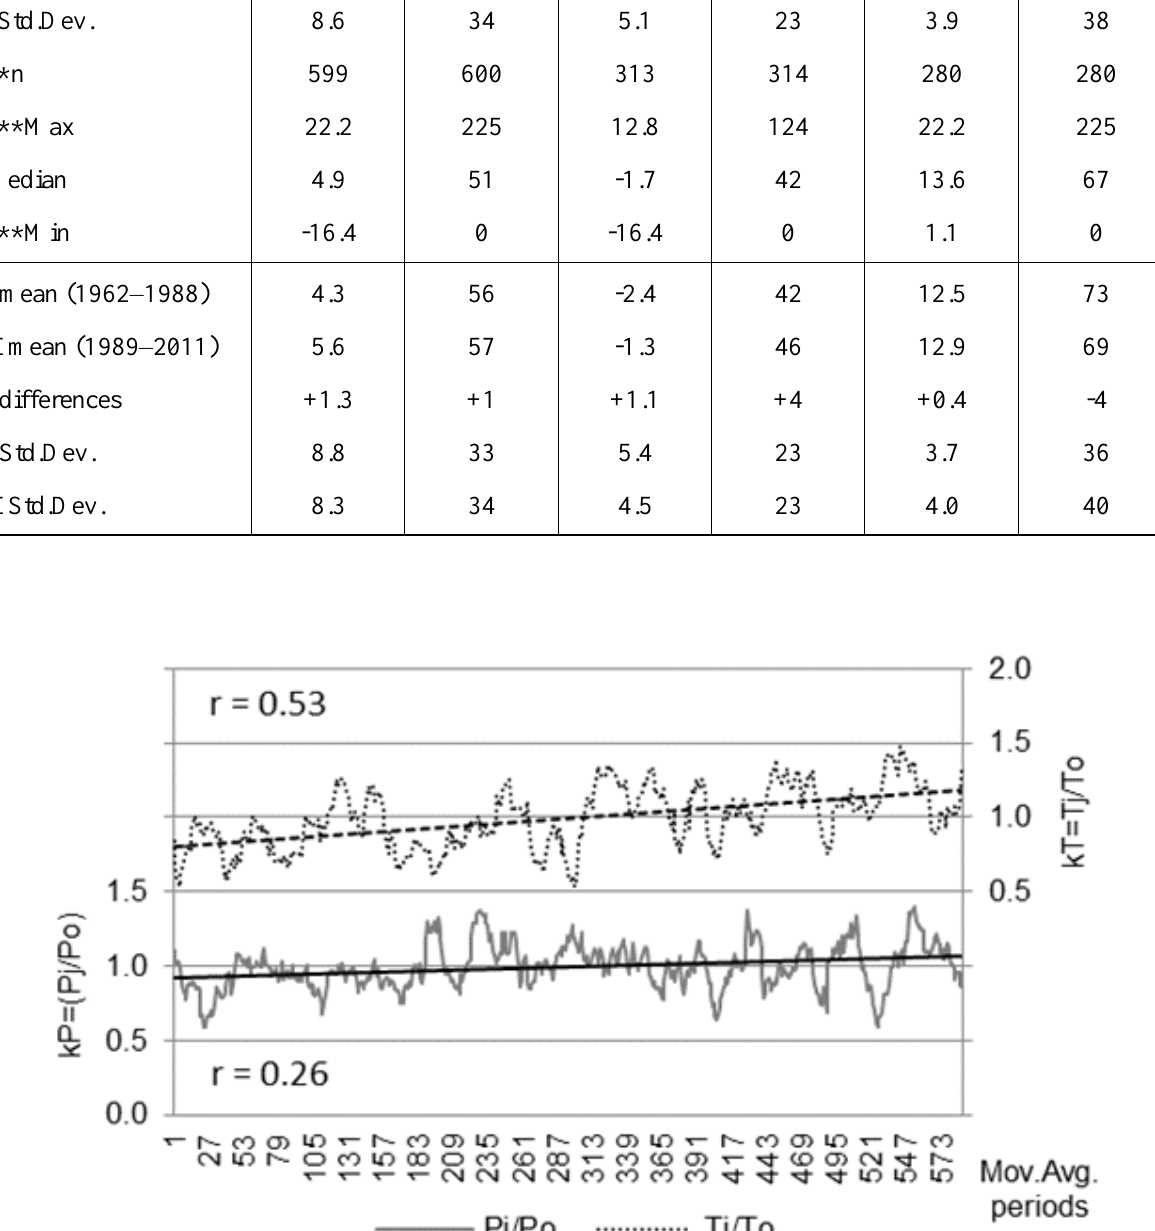
) and precipitation (P) data recorded at the Tooma air